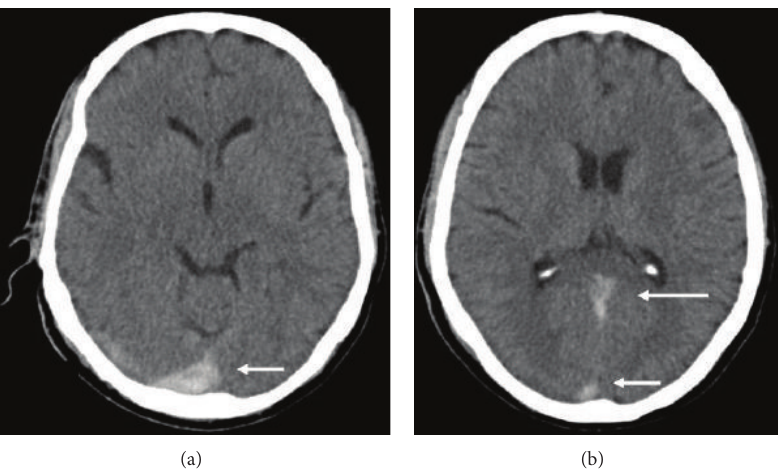
Figure 1: First CT scan brain without contrast showing suspicion of subarachnoid bleed. (a) Hyperdensity involving the posterior most portion of falx cerebri and extending to right (white arrow)-(trickling trail of blood); (b) hyperdensity extending along falx cerebri posteriorly (white arrow long) and marginally to the right (white arrow